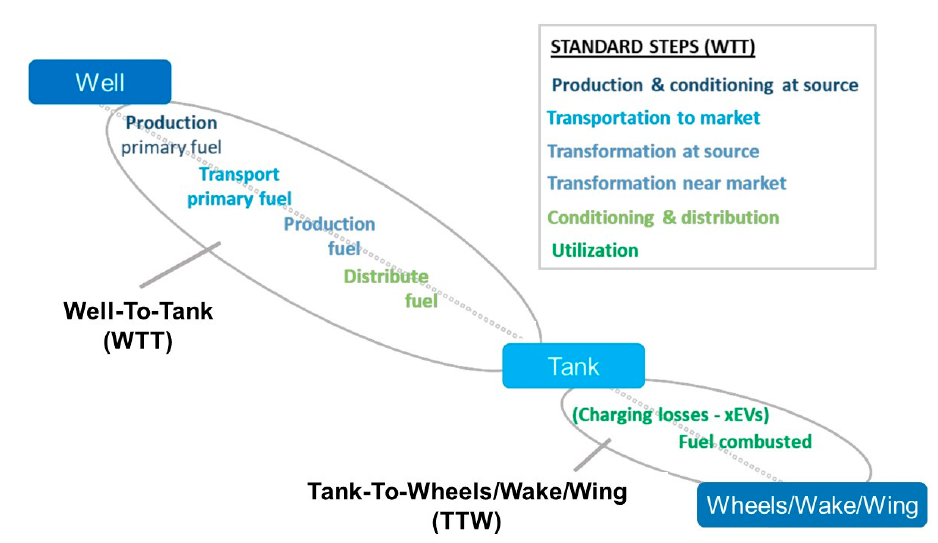
Figure 1. Well-to-wheel/wake/wing emissions for fuel supply chains .